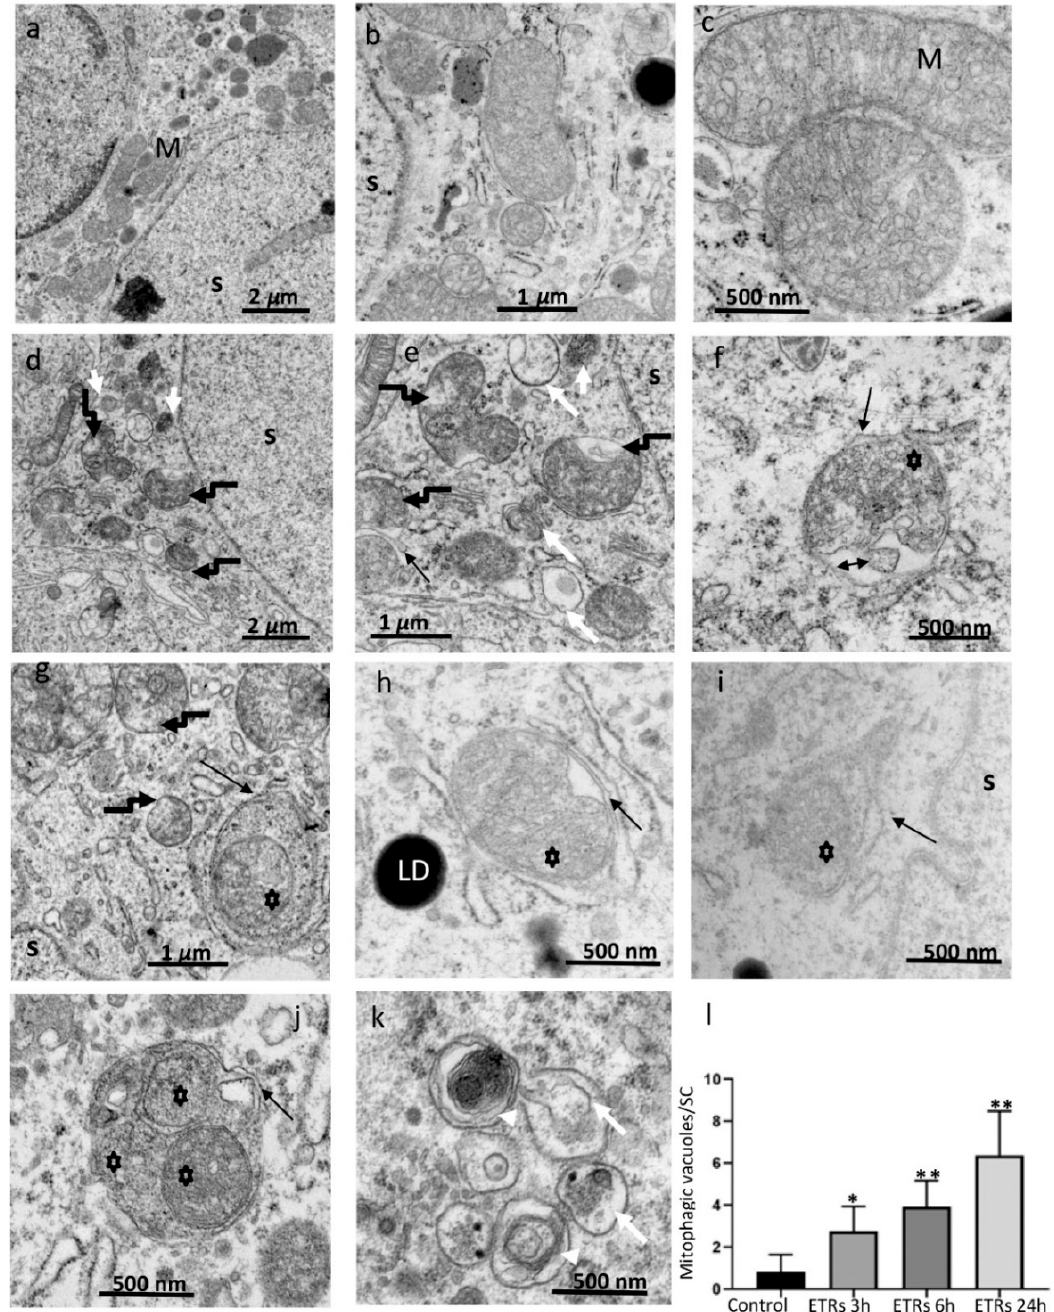
Figure 1. Ultrastructural characteristics of enhanced mitochondrial damage and mitophagy in ethanol-treated rats (ETR) Sertoli cells (SCs.) ( a – c ): control testes; ( d – k ): ETRs. Quantification of mitophagy is shown in ( l ). Note the normal mitochondria (M) in control testes with characteristic vesicular-type cristae. Broken black arrows ( d,e,g ) indicate damaged mitochondria in ETR SCs, while black arrows show autophagosomal membranes engulfing damaged mitochondria (asterisks) forming mitophagosomes. The double-head arrow indicates damaged fragmented cristae. The long and short white arrows mark autolysosomes and lysosomes, respectively. White arrow heads mark multilamellar bodies. LD: lipid droplets; S: SC nucleus. The histogram depicts quantification of mitophagic vacuoles in the control and ETRs. * p < 0.01 and ** p < 0.001 vs. control (one-way analysis of variance (ANOVA)).